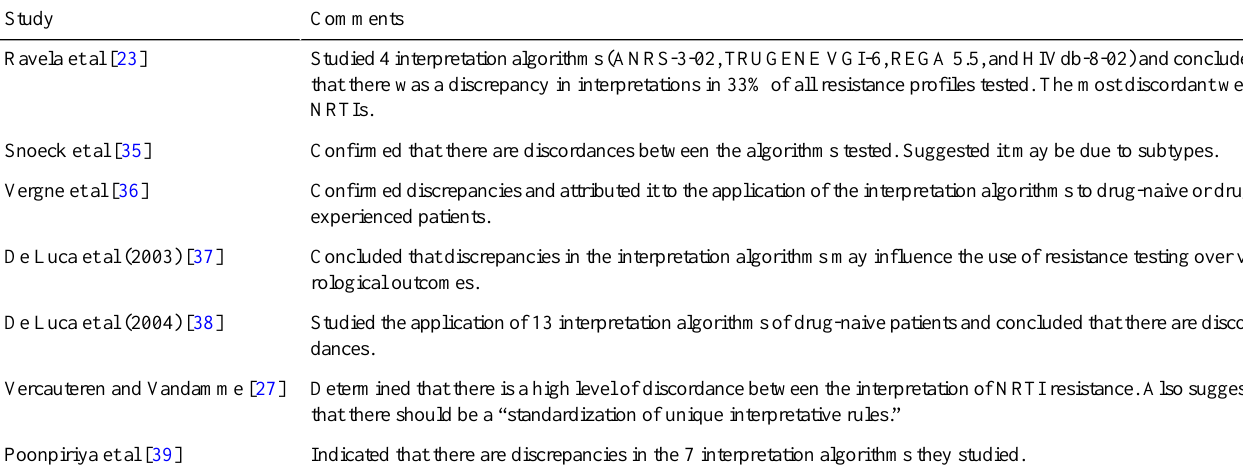
Table 6. Summary of discrepancies reported using various interpretation